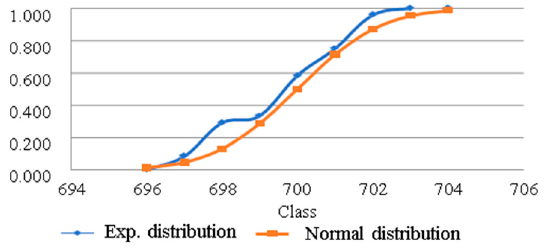
Figure 2. The normal and experimental data distribution.